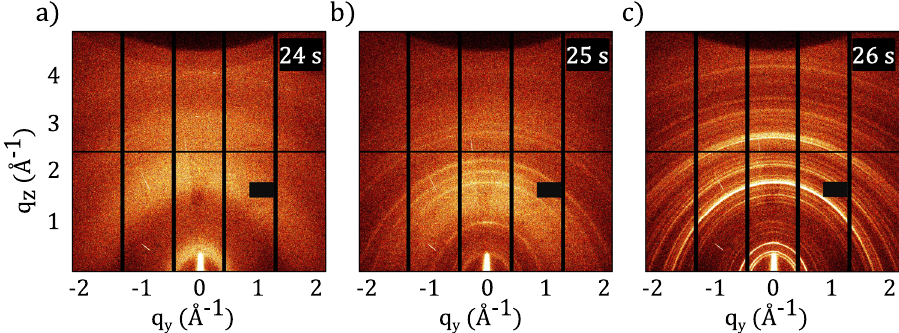
Fig. 2 Structural conversion seen in 2D GIWAXS data. 2D GIWAXS data as a function of the scattering vector components q y and q z during structural conversion of MAPI thin fi lm ( a ) before, ( b ) during and ( c ) after the antisolvent drop at t = 25 s. Diffraction from ( a ) colloidal mixture of solid precursors and solvent molecules, (b) instantly nucleated crystalline MAPI nanocrystals and nutrient colloidal phase in the slight background, and ( c ) crystalline orthorhombic MAPI·DMSO During the experiment, four equilibrium phases and three tran- sient conversion processes are registered as explained below. Phase I . In the fi rst phase (phase I, t = 0 – 24 s), the liquid pre- cursor is spin-coated and re fl ected as diffuse halos centered